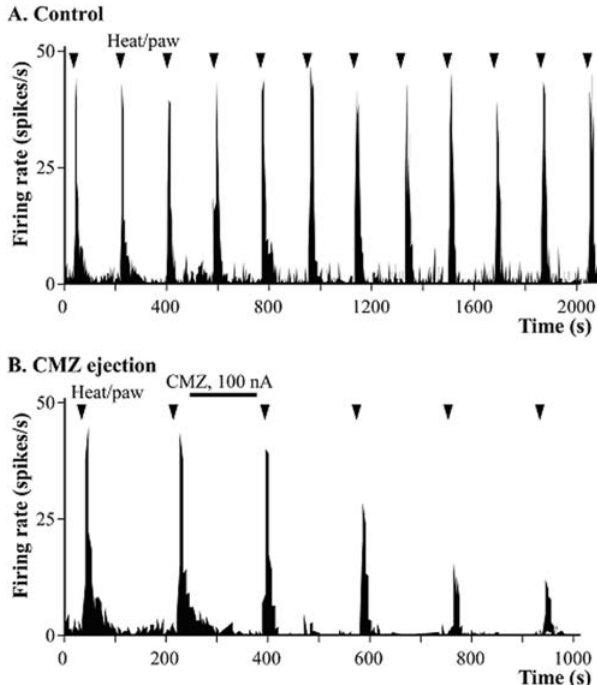
Figure 7. Heat-induced pain signal inhibition of the best Ca 2 + - calmodulin inhibitor in the rat. Ratemeter recordings showing the inhibitory effects of calmidazolium (CMZ) on responses of a spinal dorsal horn neuron to noxious heat delivered to its cutaneous receptive field on the paw. Panel A: Heat-evoked responses evoked in every 3 min during the control period.. Panel B: Effects of iontophoresed CMZ on the heat-evoked responses. Similar results were obtained in five additional experiments. A representative recording is